Question: Give a one-sentence summary of this figure.
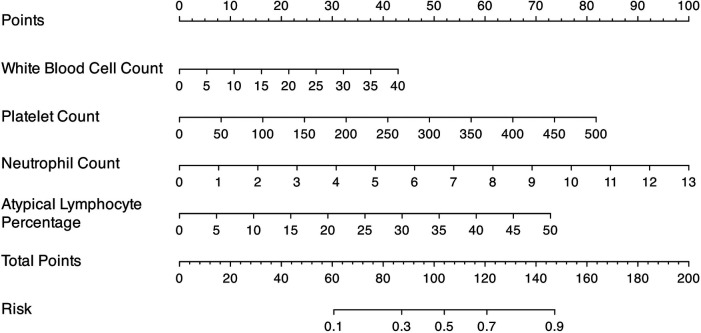
Answer: Nomogram for predicting the risk of prolonged fever in immunocompetent children with primary EBV infection. The total score, calculated by summing the points assigned to the four parameters (WBC, NEU, PLT, and AL), corresponds to the predicted probability of fever duration >1 week. EBV, Epstein–Barr virus; WBC, white blood cell count; NEU, neutrophil count; PLT, platelet count; AL, atypical lymphocyte proportion.